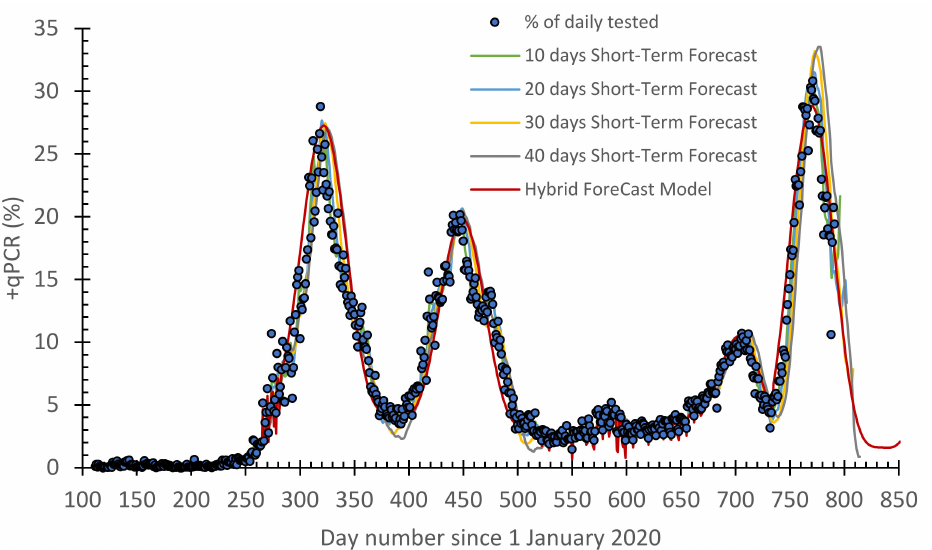
Figure 3. A timeline for the daily reported +qPCR tests overlayed by the short-term forecast (STF, with 10–40 days learning) model and compared with the hybrid forecast (HF) model for the COVID-19 pandemic in Jordan.